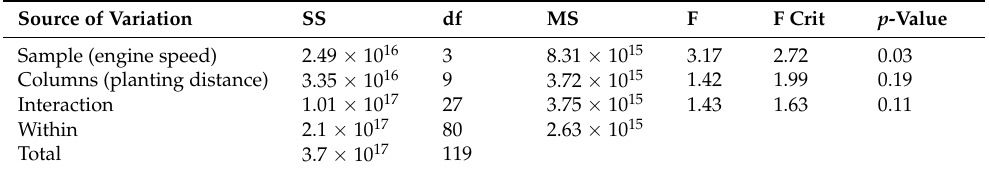
Table 3. The ANOVA result of fatigue life at location S_14 according to engine speed and planting distance. Source of Variation SS df MS F F Crit p -Value Sample (engine